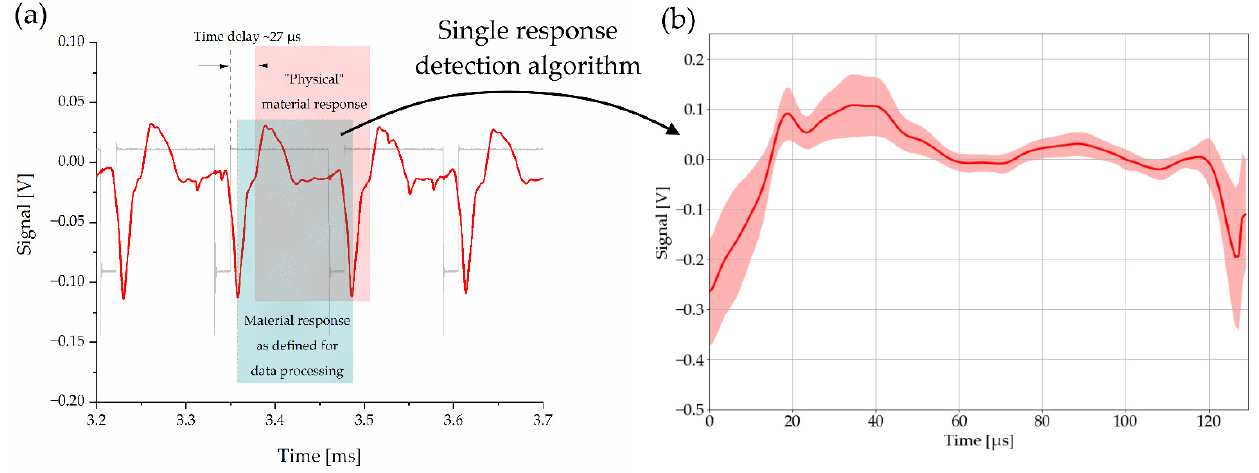
Figure 4. ( a ) Laser-acoustic signal during a laser salvo: the red rectangle marks a “physical material response”, which follows a single laser pulse after a time delay of ~27 µ s (propagation time of the sound wave). The green box marks the single pulse response as defined for data processing. For a continuous pulse train, both contain the same data. Figure ( b ) shows the processed and averaged laser-acoustic material response of the “single pulse response-detection algorithm” applied on the signal in ( a ). The colored area around the graph corresponds to its 68% confidence